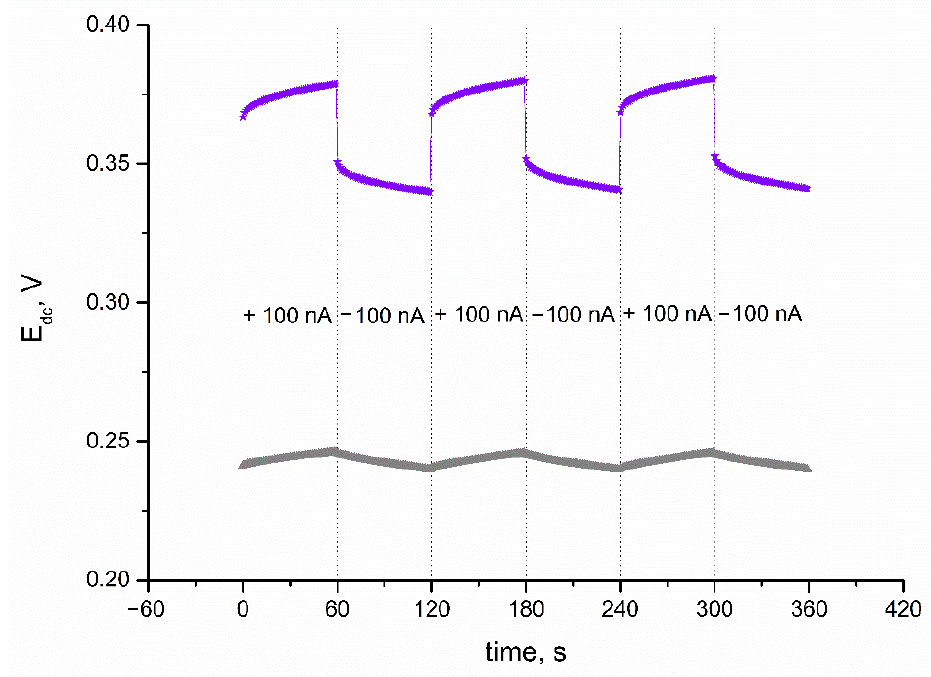
Figure 3. Chronopotentiograms recorded for IrO 2 · 2H 2 O solid-contact layer ( (cid:78) ) and GC/IrO 2 · 2H 2 O/K + -ISM electrode ( (cid:70) ) with the current flow of 100 nA.